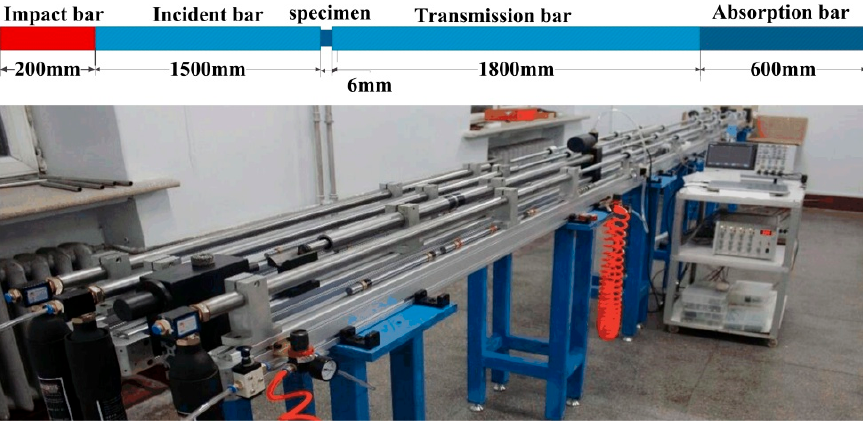
Figure 3. Separate Hopkinson pressure bar (SHPB) experiment device.